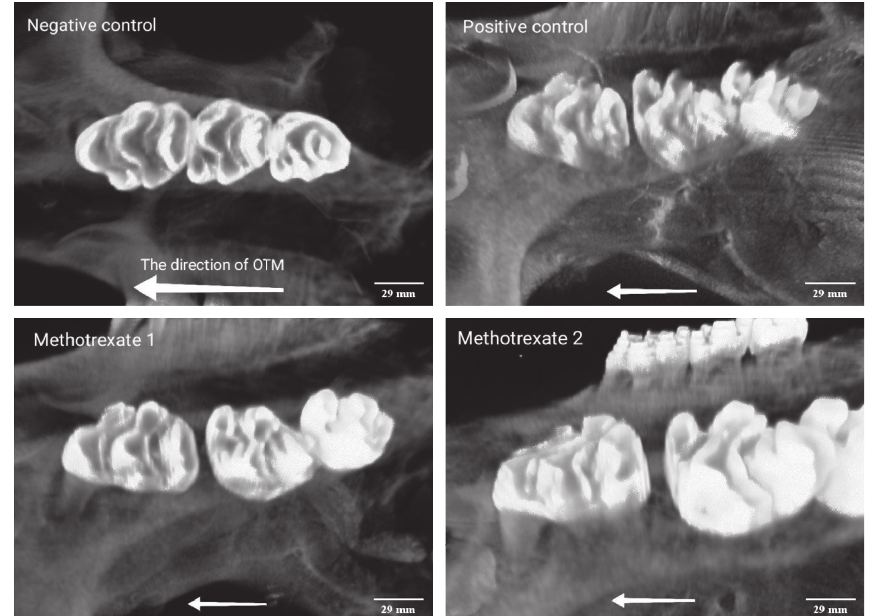
Figure 3: Micro-CTimage analysis of orthodontic tooth movement (OTM) after 21 days of force application: the negative control group (no OTM and no injection), positive control group (OTM and saline injection), and experimental groups injected with 0.75 and 1.5mg/kg methotrexate. Scale bar: 29mm. Magnification: 2.7. Table 1: Mean and standard deviation of orthodontic tooth movement (mm) in the four groups.